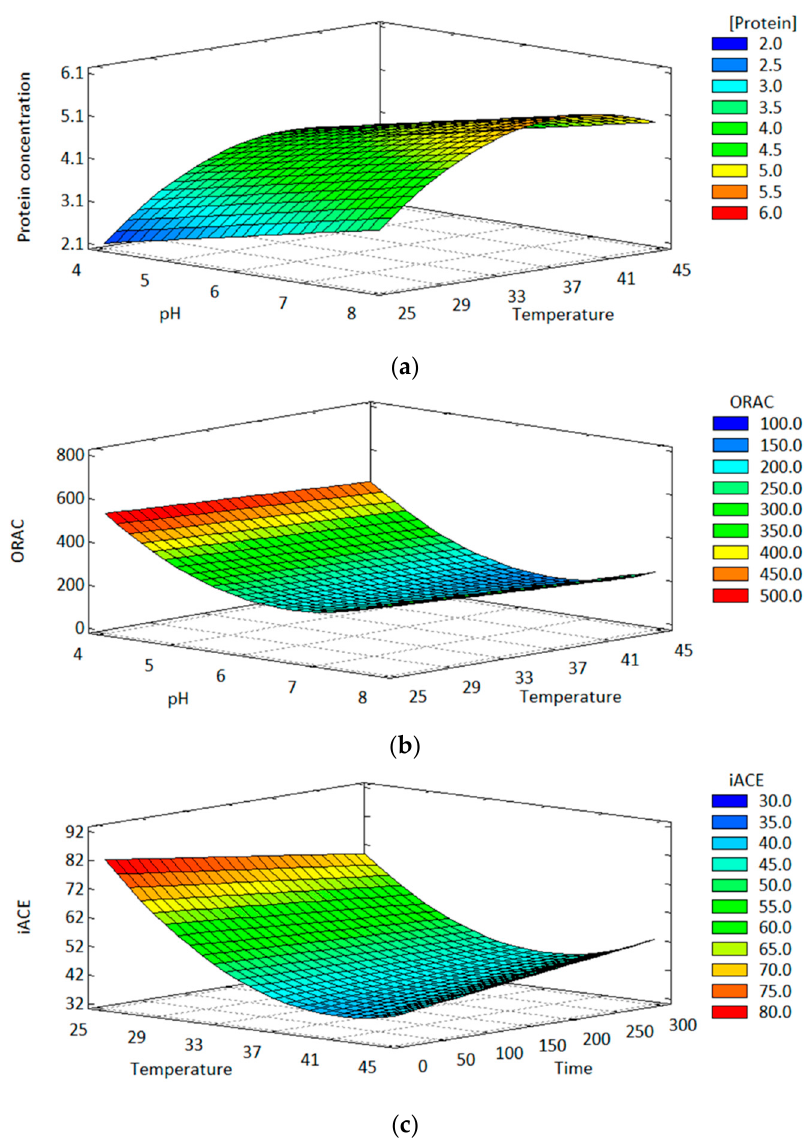
Figure 4. Response surface models. Each response is based on two experimental factors keeping the third factor at its central level. Charts for: protein concentration ( a ); ORAC ( b ); iACE ( c ). Table 2. Factor’s levels that optimise each response and the corresponding predicted optimal response value. Factors † Model Response ‡ Factors X A Model